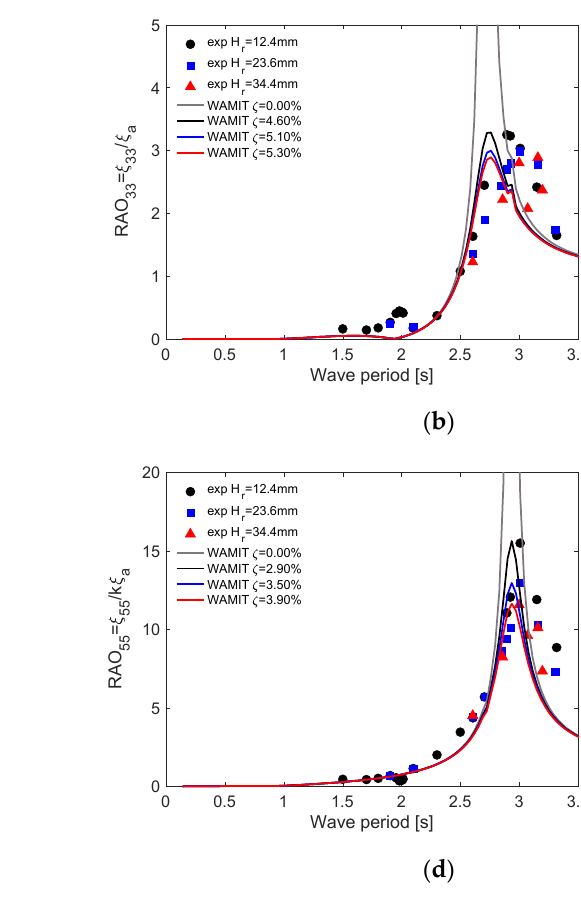
Figure 13. Response amplitude operator (RAO) result comparisons between the experiment and numerical calculations for the Semi ‐ spheroid model and different wave heights: ( a ) heave, NK ‐ UTWind, ( b ) heave, WAMIT, ( c ) pitch, NK ‐ UTWind, and ( d ) pitch, WAMIT code calculations. Figure 14e,f show the RAO of strains for the Semi ‐ spheroid model at the tower base Strain RAOs at the tower base and the deck, both around the Y axis, were presented to and deck around the Y axis, respectively. discuss the inner forces, as shown in Figure